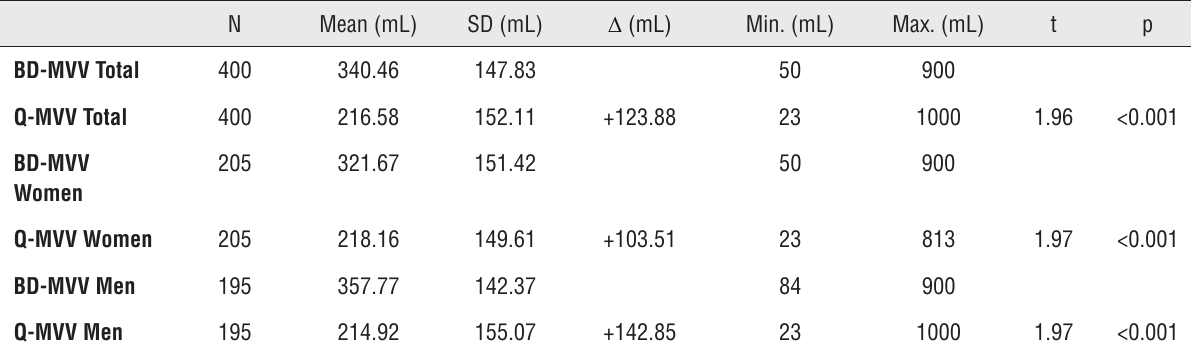
Table 1 - Results of independent two sample t-tests comparing mean BD-MVV to Q-MVV in the total sample, and across women, and men.